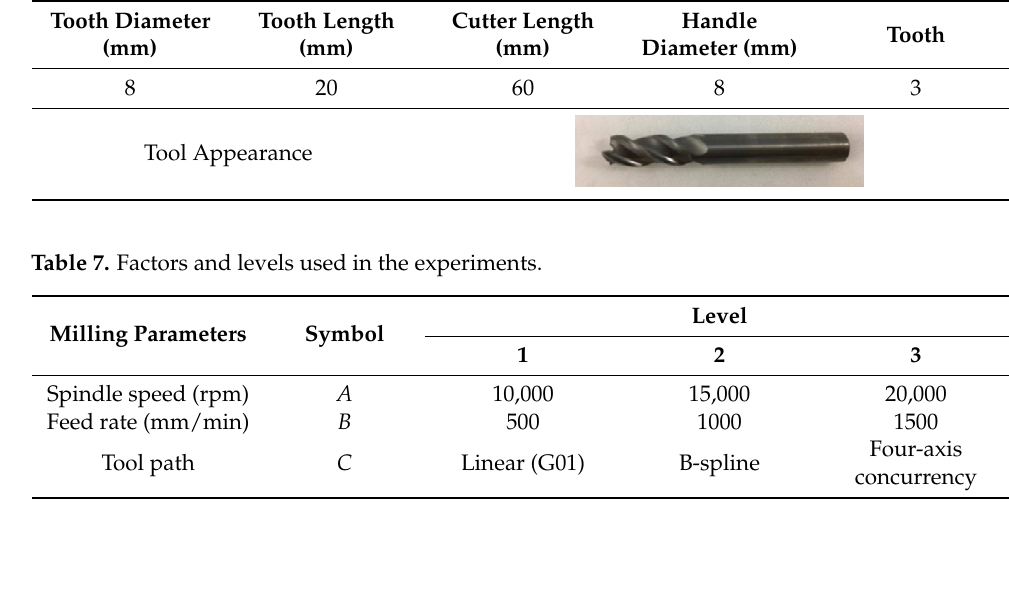
Table 6. Specifications of the 7 leaders E143-8 cutter.